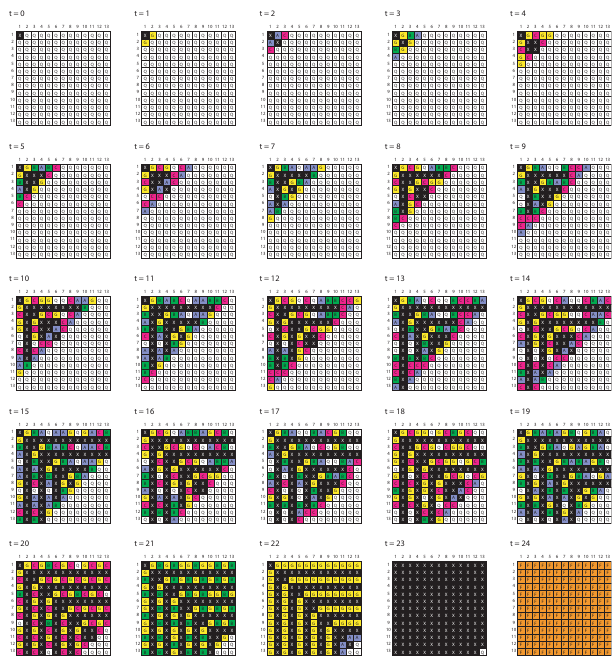
Fig. 3. Snapshots of the optimum-time synchronization process on a 13 × 13 square